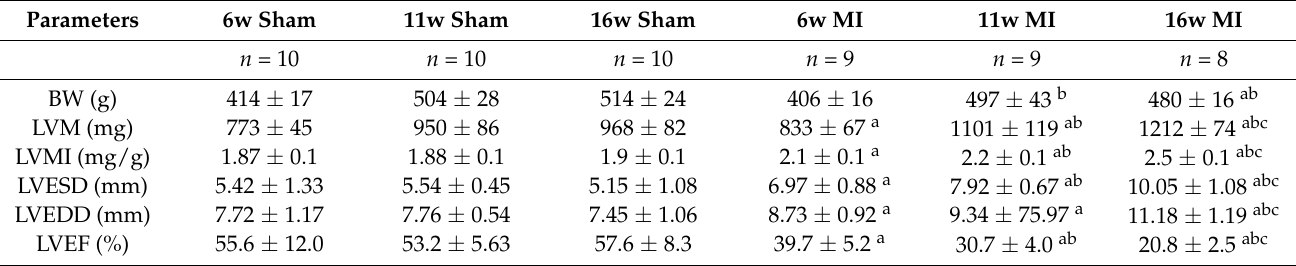
Table 1. Left ventricular mass index and cardiac function.